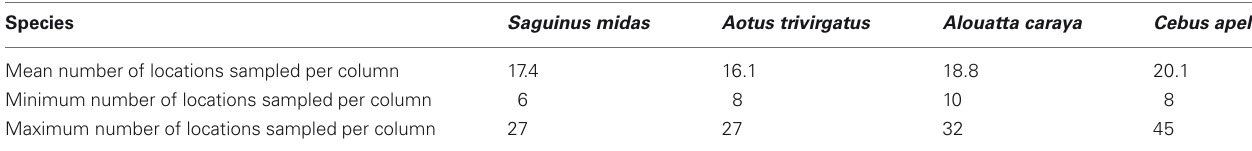
Table 2 | Numbers of sites along a sampling axis at which counts were made to determine neuron density. Species Mean number of locations sampled per column